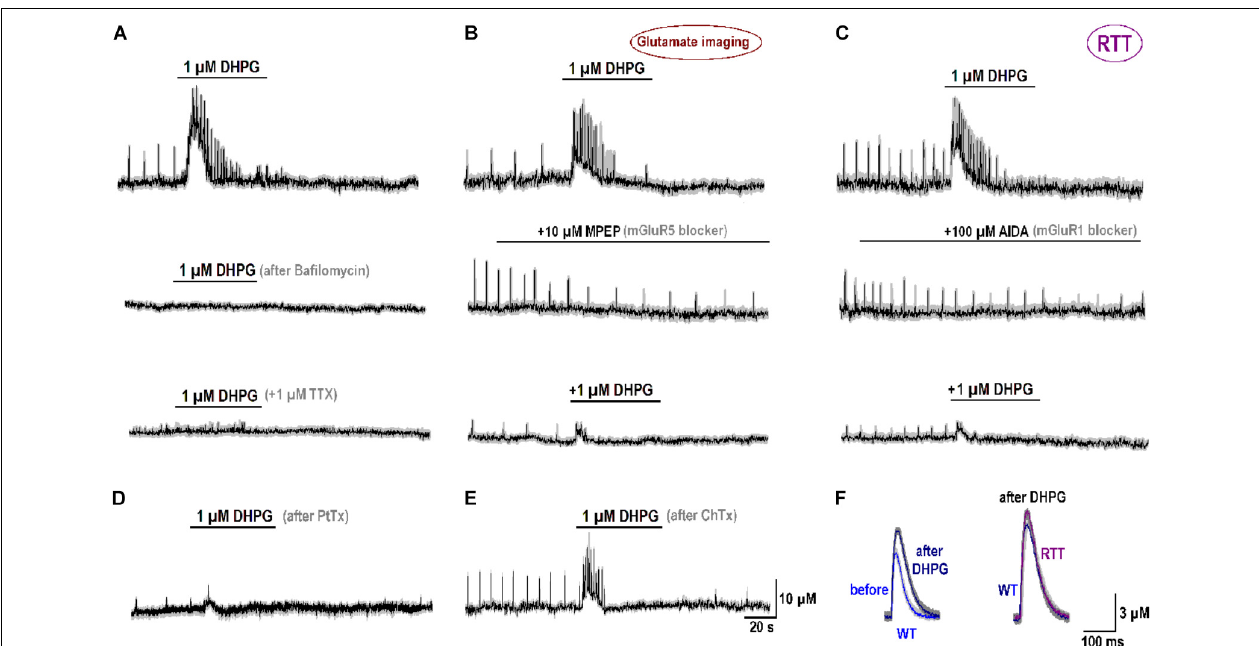
FIGURE 5 | Specificity of mGluR1/5 effects. (A) Glutamate release induced 1 µ M DHPG (mGluR1/5 agonist; top trace, “control”), The effects was abolished after treatment for 30 min with 1 µ M bafilomycin (a blocker of vesicular glutamate uptake, second trace) and 1 µ M tetrodotoxin (TTX, bottom trace). (B) mGluR5 blocker MPEP diminished amplitude and frequency of spontaneous glutamate spikes (middle panel) and the effects of DHPG (top vs. bottom traces). (C) mGluR1 blocker AIDA suppressed glutamate spikes (middle panel) and reduced the effects of subsequent application of DHPG (top vs. bottom traces). (D) After treatment of the slices for 24 h with 1 µ M/ml PtTx (1 µ g/ml), the amplitude and frequency of spontaneous glutamate transients and a stimulatory effects of DHPG were significantly reduced ( n = 4). (E) Neither glutamate spikes nor their augmentation by DHPG were modified after 24 h with Cholera toxin (ChTx, 1 µ g/ml). (F) Modifications of single glutamate spikes after DHPG. The data were collected using fast imaging (acquisition time, 2 ms). The left panel compares glutamate spikes obtained in WT slices that initially showed weak activity. The traces before and 10 min after DHPG are overlaid. Their comparison clearly indicates increase in the amplitude and decay after the treatment. The right panel compares typical glutamate spikes in WT and RTT that after DHPG became virtually